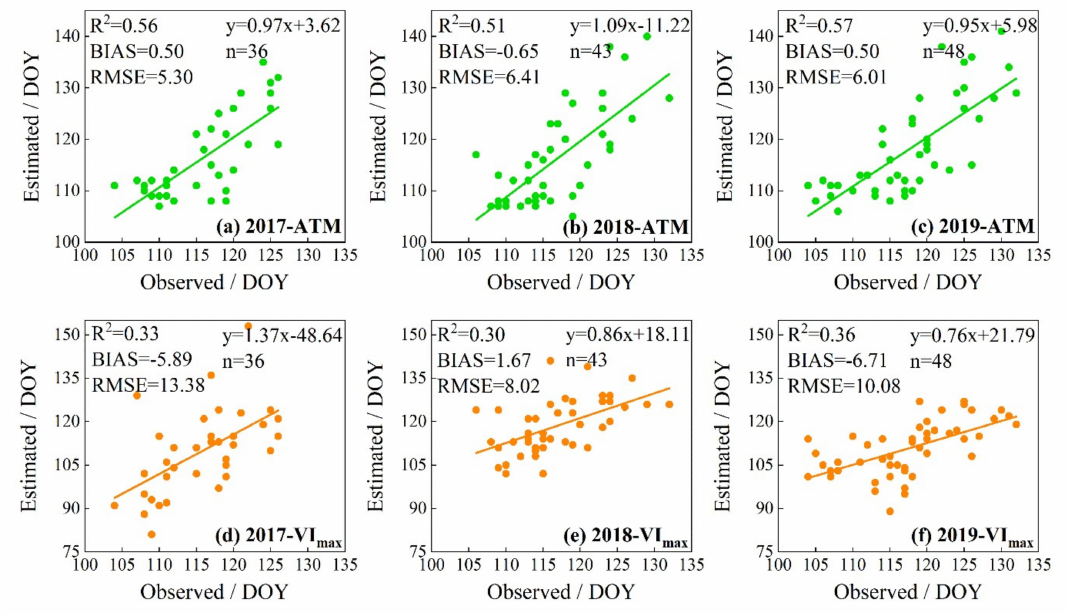
Figure 6. Scatter plot between observed flowering dates and estimated ones. ( a – c ) the proposed ATM method for 2017, 2018 and 2019, respectively; ( d – f ) the VI max method for 2017, 2018 and 2019, respectively. DOY: Julian day of